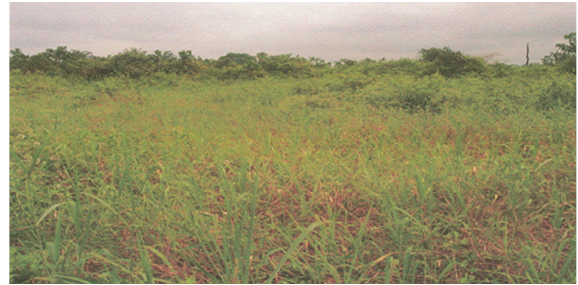
Figure 5: Forest ecosystems are converted to savannah due to frequent use of fire along the Ekondo-titi-Mundemba major